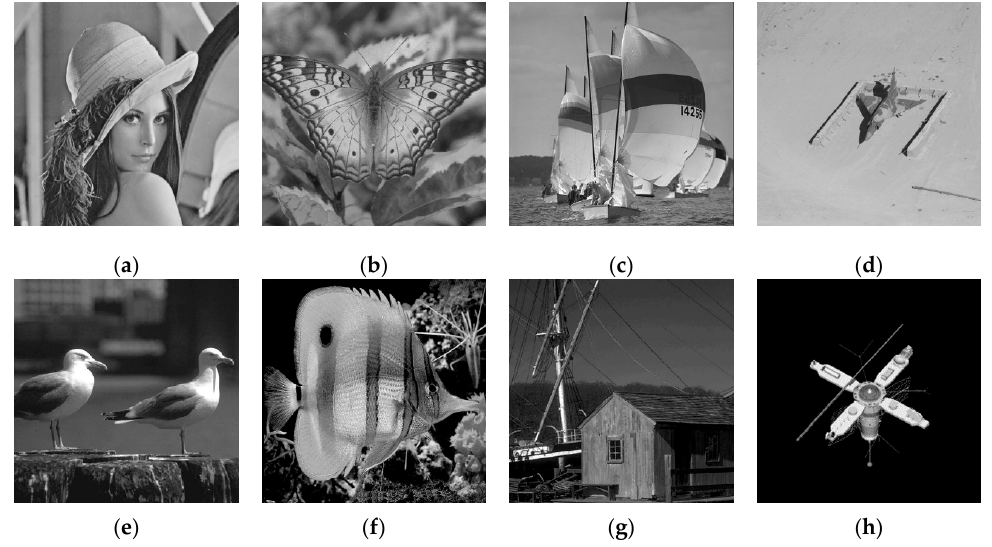
Figure 3. Test images: ( a ) Lena, ( b ) butterfly, ( c ) boat, ( d ) plane, ( e ) seabird, ( f ) fish, ( g ) house, and ( h ) satellite.